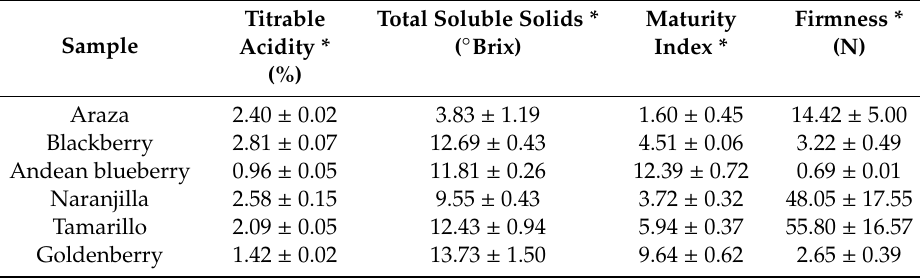
Table 2. Physical and chemical parameters related to the maturity stage of the fruits.